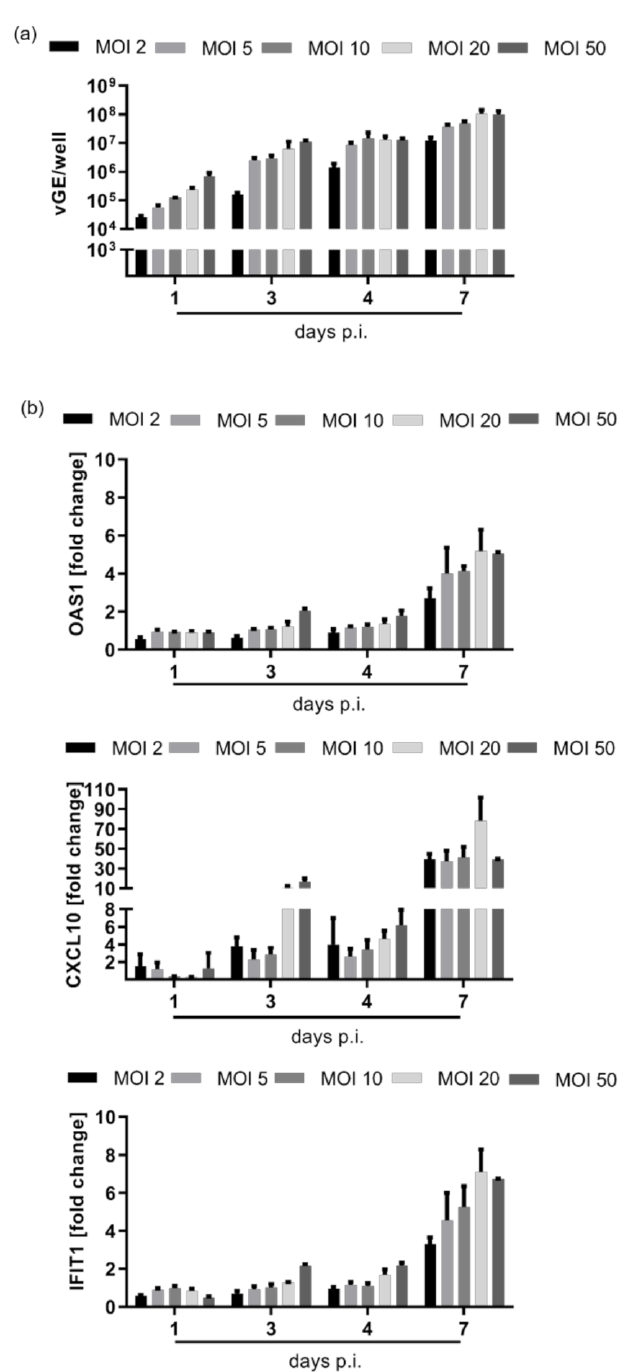
Figure A1. Dose-dependent increase in HDV replication and ISG expression. HepG2-NTCP cells were seeded in a 24-well plate, infected with HDV at the indicated MOI (vp/cell) and extracted RNA was subjected to qRT-PCR. ( a ) Absolute numbers of vGE/well detected in HepG2-NTCP cells. Bars represent one single experiment with biological triplicates. ( b ) ISG OAS1, IP10 and IFIT1 upregulation in HDV-infected HepG2-NTCP cells is given as fold induction relative to non-infected cells. Graph depicts a single experiment with biological